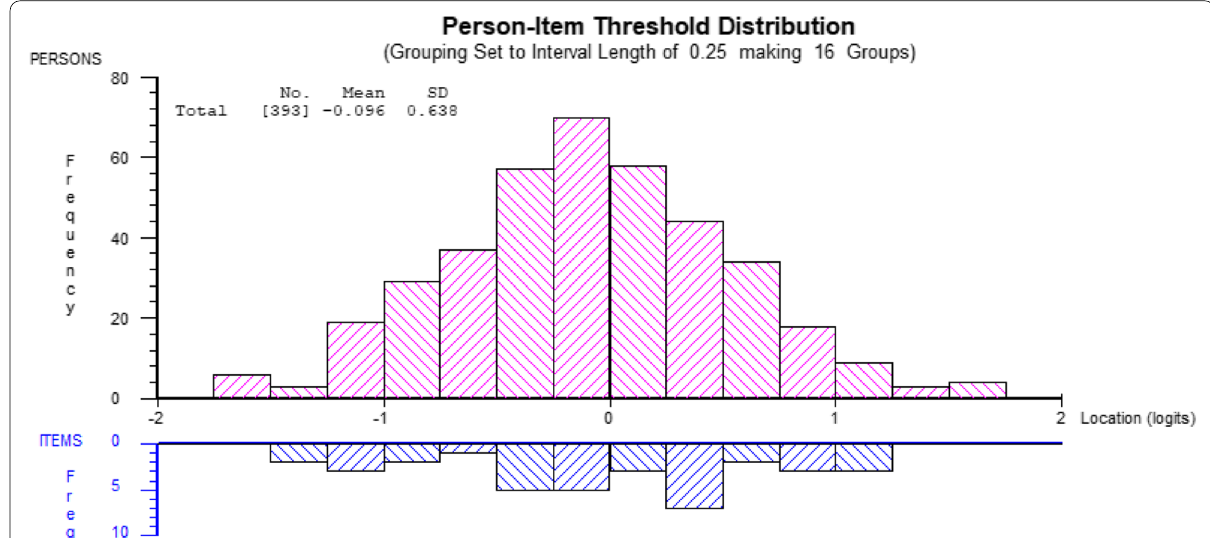
Fig. 1 Distribution of person‑item thresholds of the best‑fit Rasch analysis of the Arabic CPQ (sample